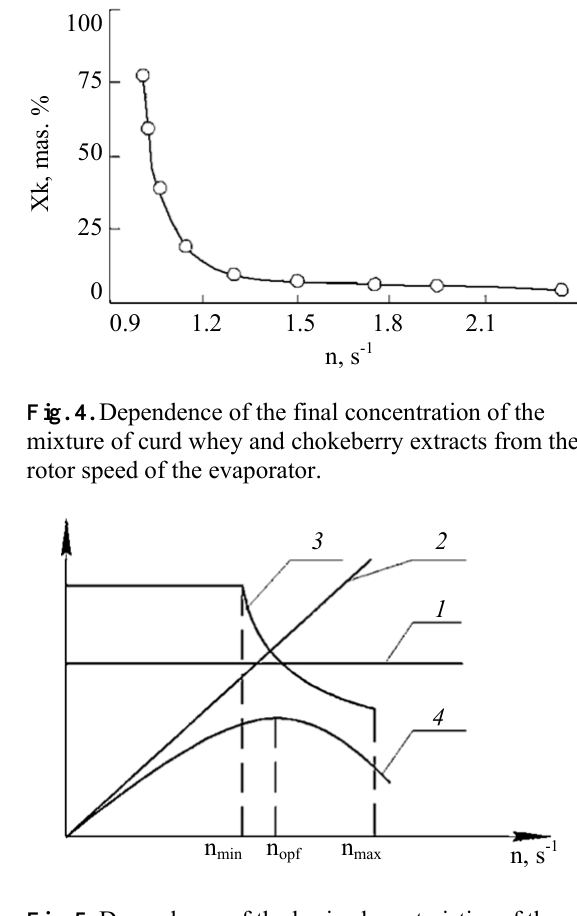
Fig. 5. Dependence of the basic characteristics of the evaporator on the rotor speed: ( 1 ) the heat flow Q, W, ( 2 ) the initial mass flow rate G H , kg/s, ( 3 ) the final liquid concentration X K , wt. %; ( 4 ) the efficiency for the secondary steam W, kg/s.